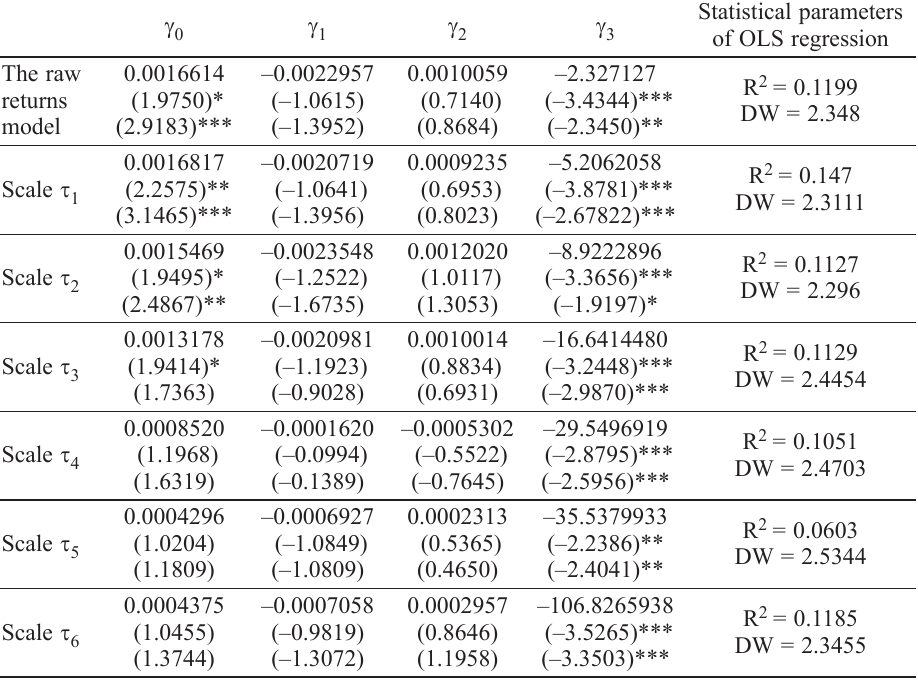
Table 5. OLS and GMM results of testing the CAPM implications for Hungarian stock